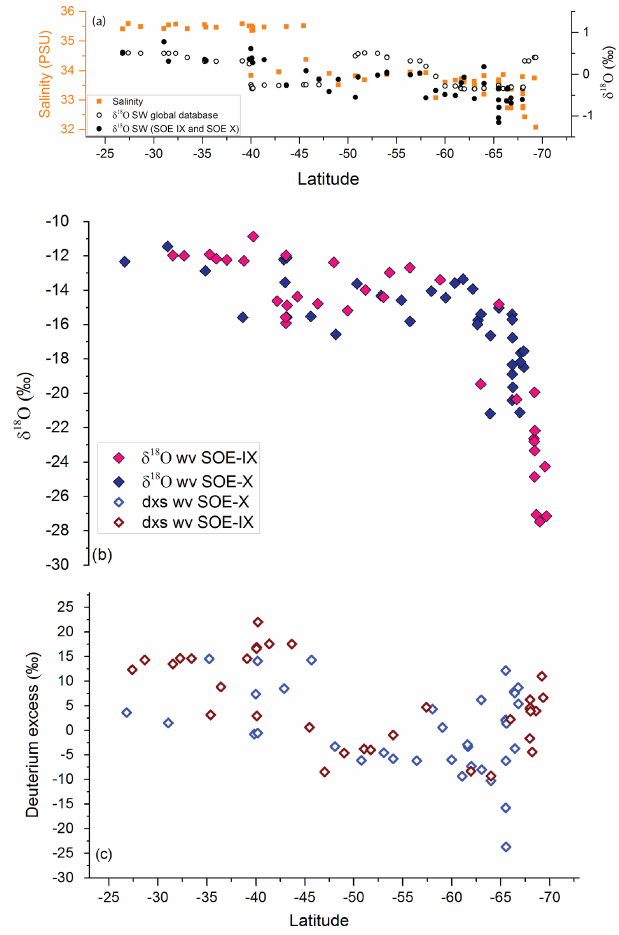
Figure 4. (a) Measured δ 18 O sw as black filled circles and values of surface water isotopic composition extracted from the Global Seawater Oxygen-18 Database along the latitudinal transect (open black circles). Also plotted as orange filled squares are the salinity values along the transect. (b) Pink and purple filled diamonds depict the δ 18 O wv of water vapor samples collected during the SOE-IX and SOE-X, respectively, at height of ∼ 15m above the water sur- face. (c) Latitudinal variation in dxs in water vapor samples shown as open red and purple diamonds for SOE-IX and SOE-X, respec-